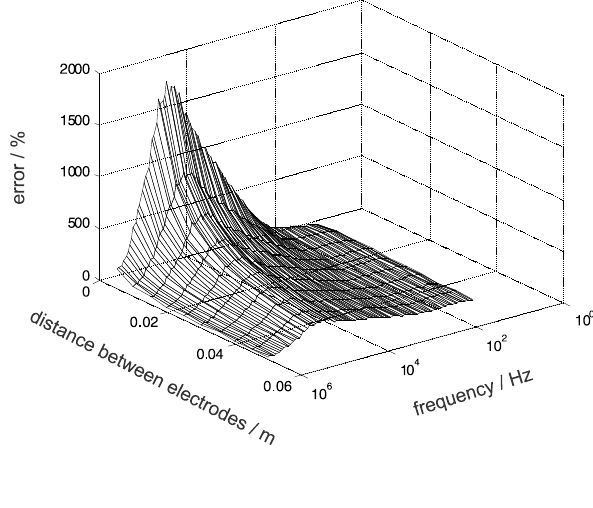
Fig. 12: Solution permittivity determination error in case the double layer is not taken into account. Frequency range is from 20 Hz to 1 MHz, the distance between the electrodes is from 5 to 45